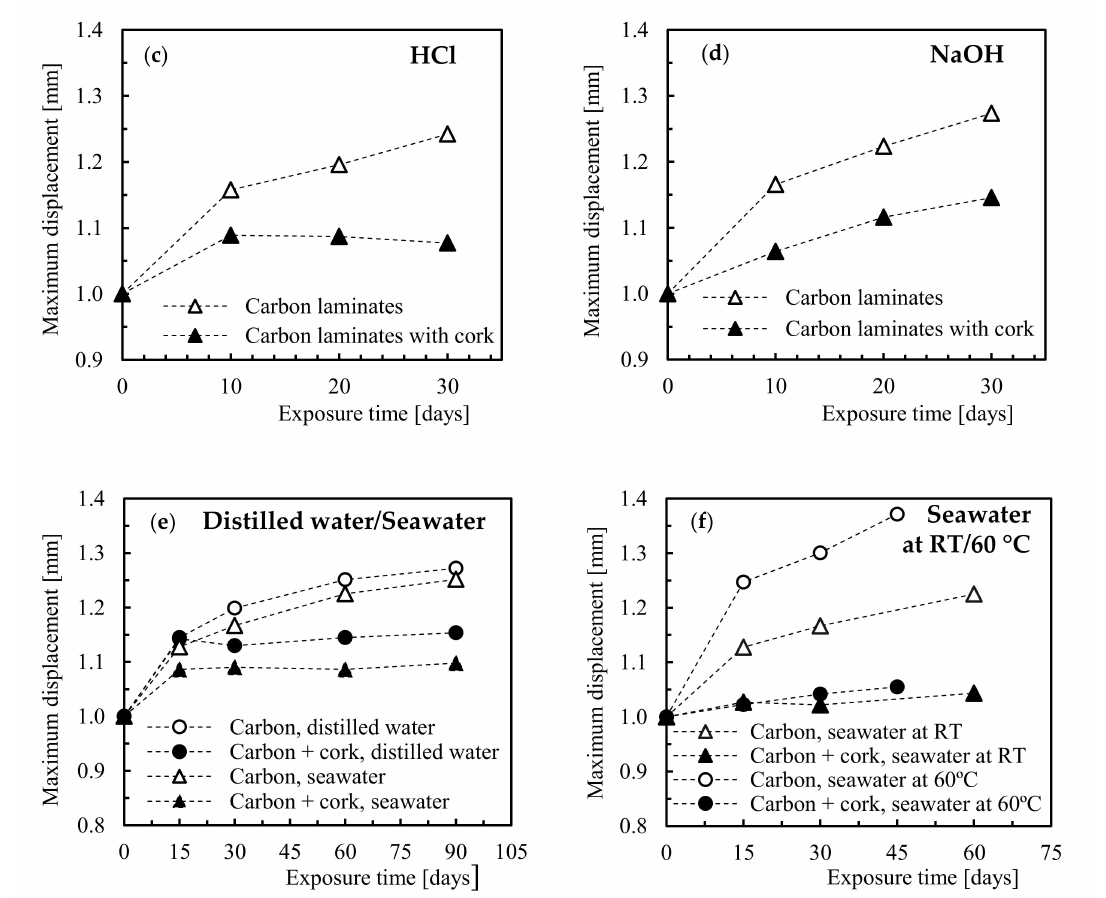
Figure 5. Influence of solution on the displacement after immersion into: ( a ) diesel; ( b ) H 2 SO 4 , ( c ) HCl, ( d ) NaOH, ( e ) distilled water and seawater; ( f ) seawater at room temperature and at 60 ◦ C.